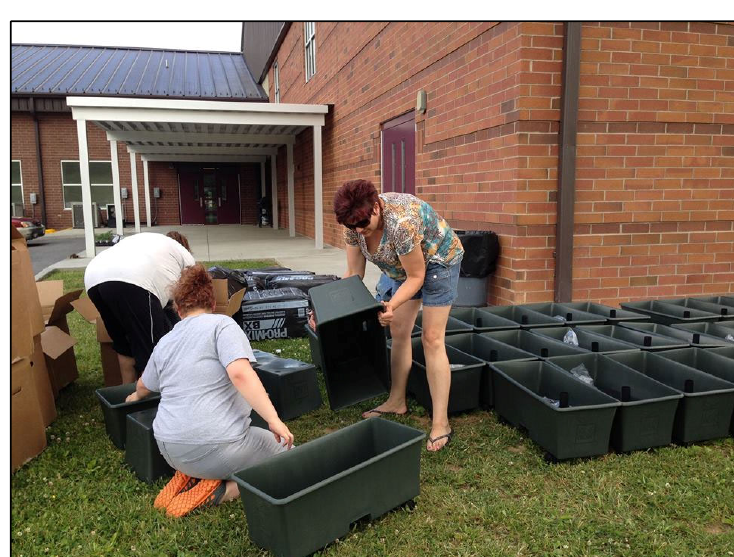
Three volunteers figure out how to assemble 50 EarthBoxes. This was shortly before a downpour began! (Photo by Kathy